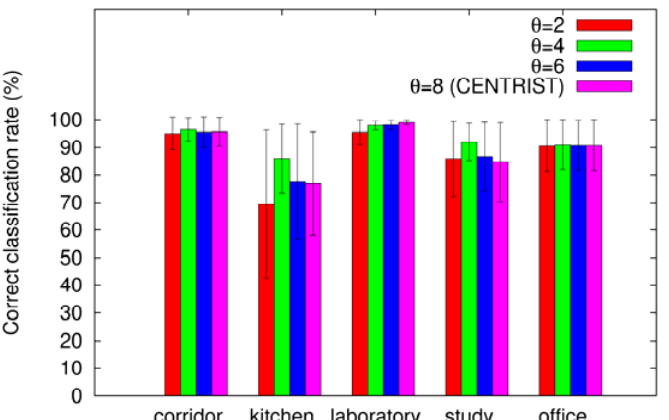
Figure 5. Correct classification rates by category using different uniformity